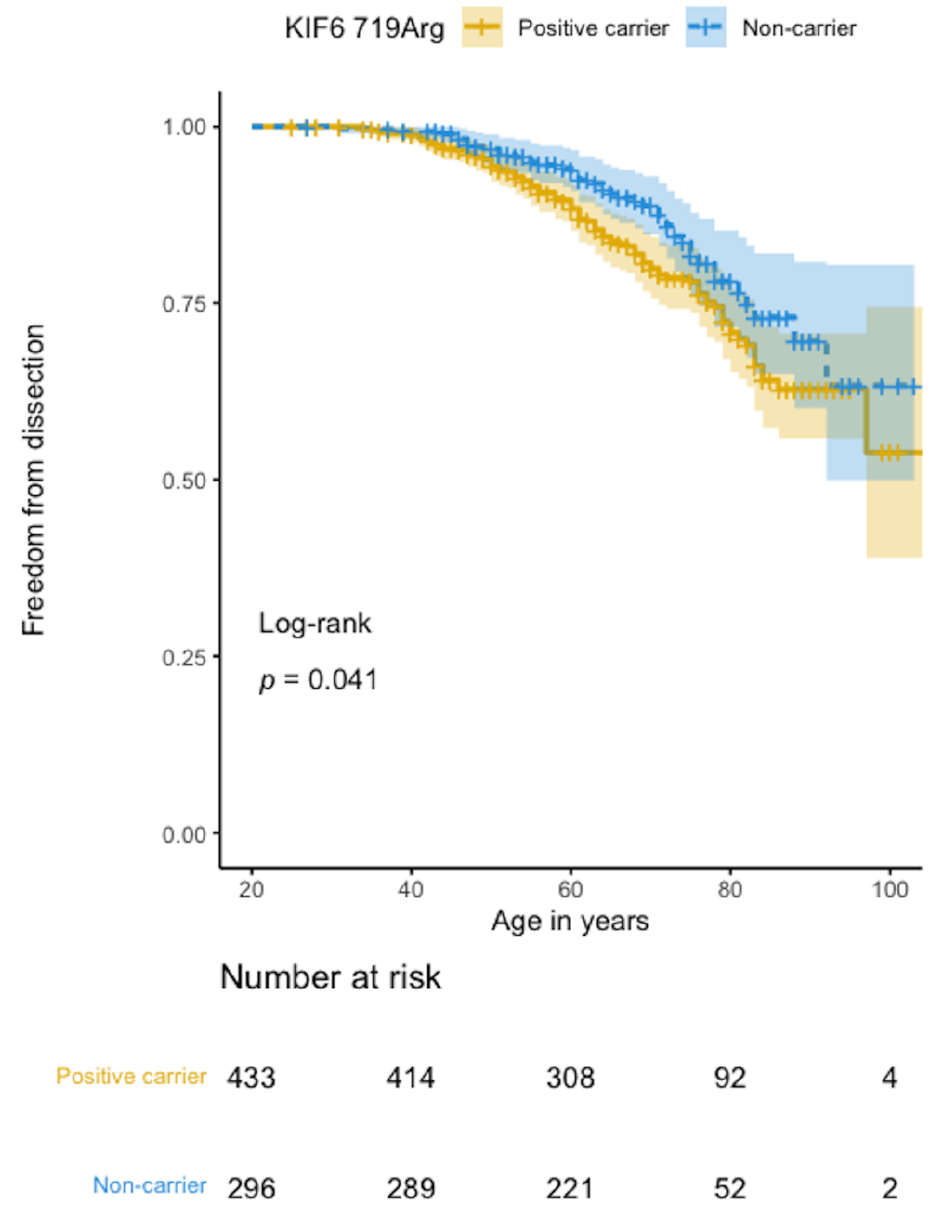
Figure 1. Kaplan–Meier estimate of freedom from aortic dissection. Note the statistically significantly increased rate of events in the positive carriers.